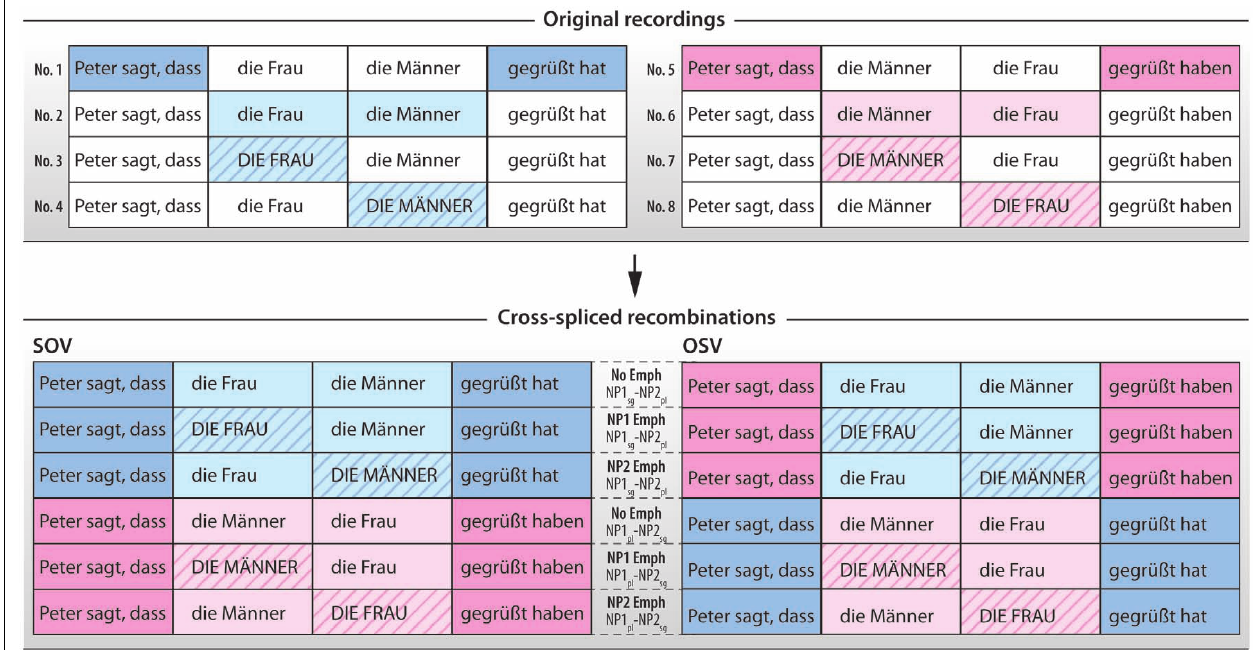
94.7%; F (1, 18) = 12.19, p < 0.005]. No Structure by